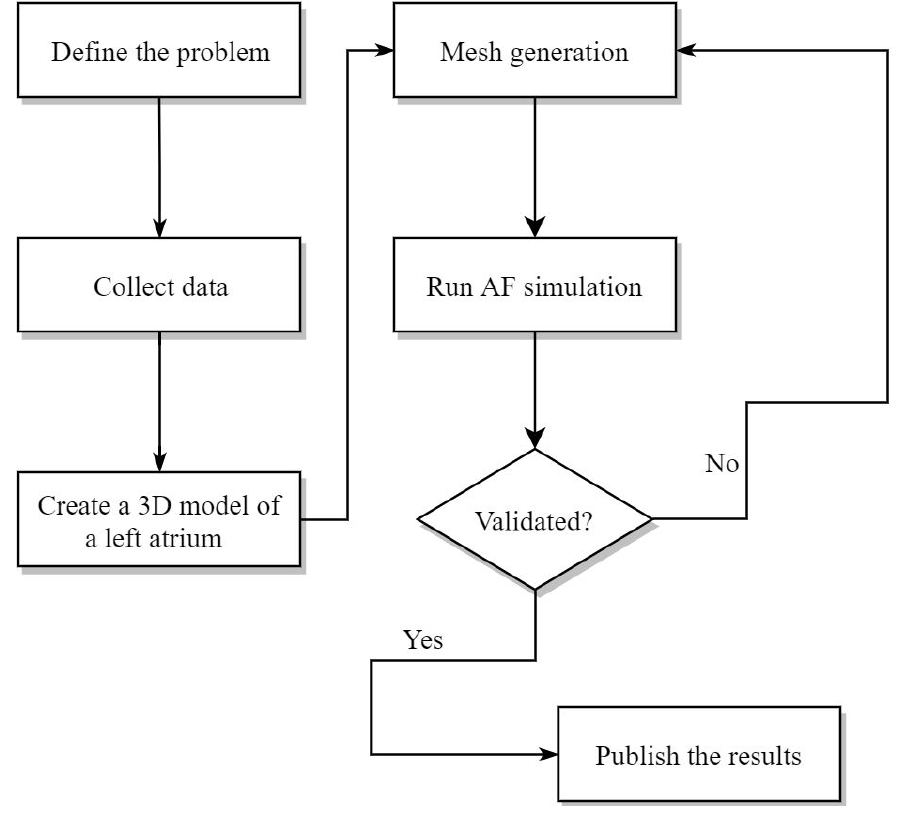
Figure 4. Basic steps of a typical AF simulation